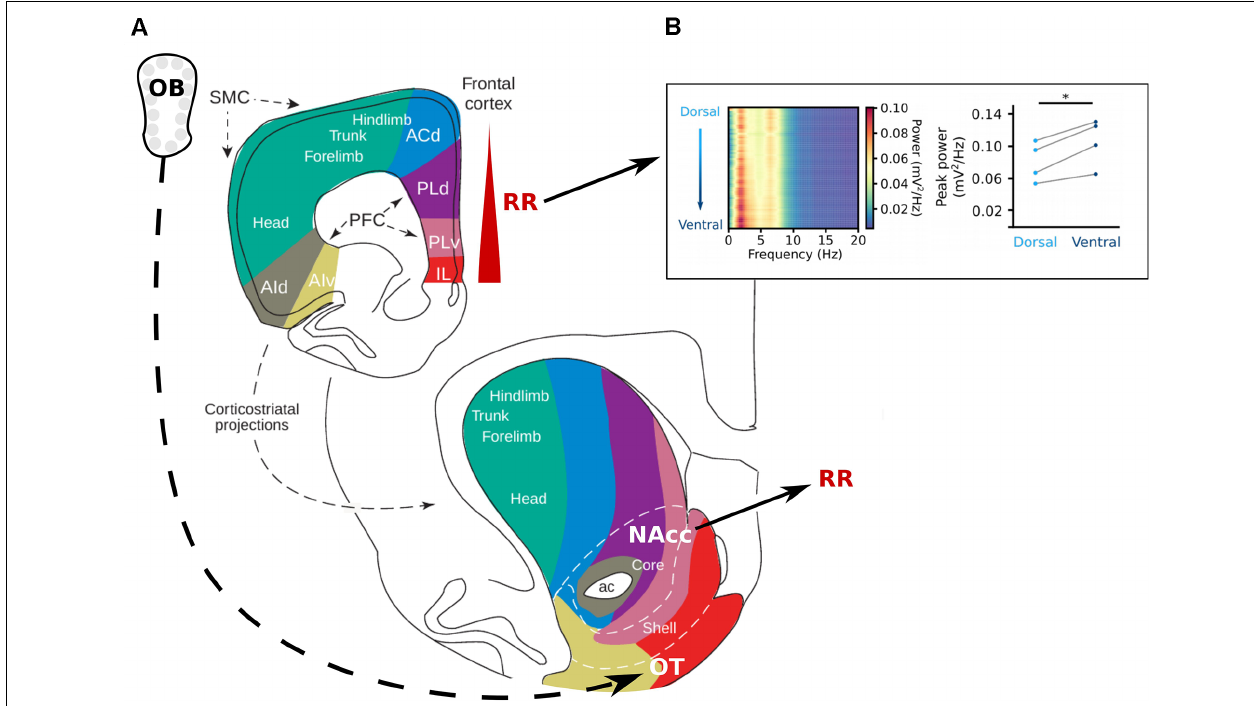
FIGURE 4 | The reward system and respiration-related oscillations. (A) Topography of the projections from the frontal cortex to the striatum. The olfactory tubercle (OT) receives direct projections from the OB and the nucleus accumbens (NAcc) has been shown to be strongly entrained by RR (Karalis and Sirota, 2018). In the prefrontal cortex, the RR power increases from dorsal to ventral (Karalis and Sirota, 2018; Folschweiller and Sauer, 2021). Adapted from Voorn et al. (2004); copyright (2004) Trends in Neurosciences, with permission from Elsevier. (B) Left: Power spectra of the mPFC along the dorsoventral axis, shows an increase in power at the frequency of respiration in the ventral direction. Left: Peak power for each mouse at 4 Hz at the most superficial recording site (light blue) and the deepest recording site (dark blue) of the mPFC. Reprinted from Folschweiller and Sauer (2021) under CC BY 4.0. ∗ p < 0.05.